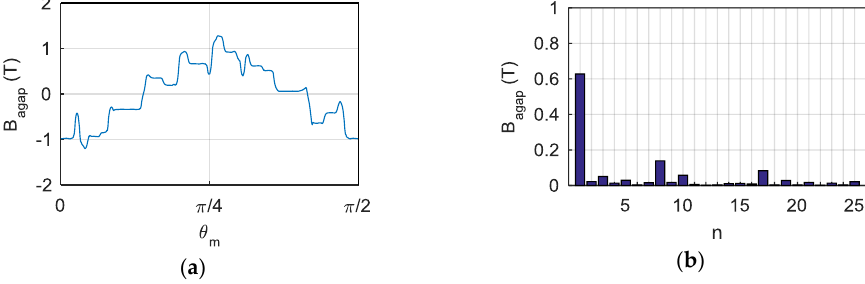
Figure 16. Air-gap flux density ( B agap ) ( a ) waveform; ( b ) harmonic spectrum; for the p = 4, Q s = 24 machine.